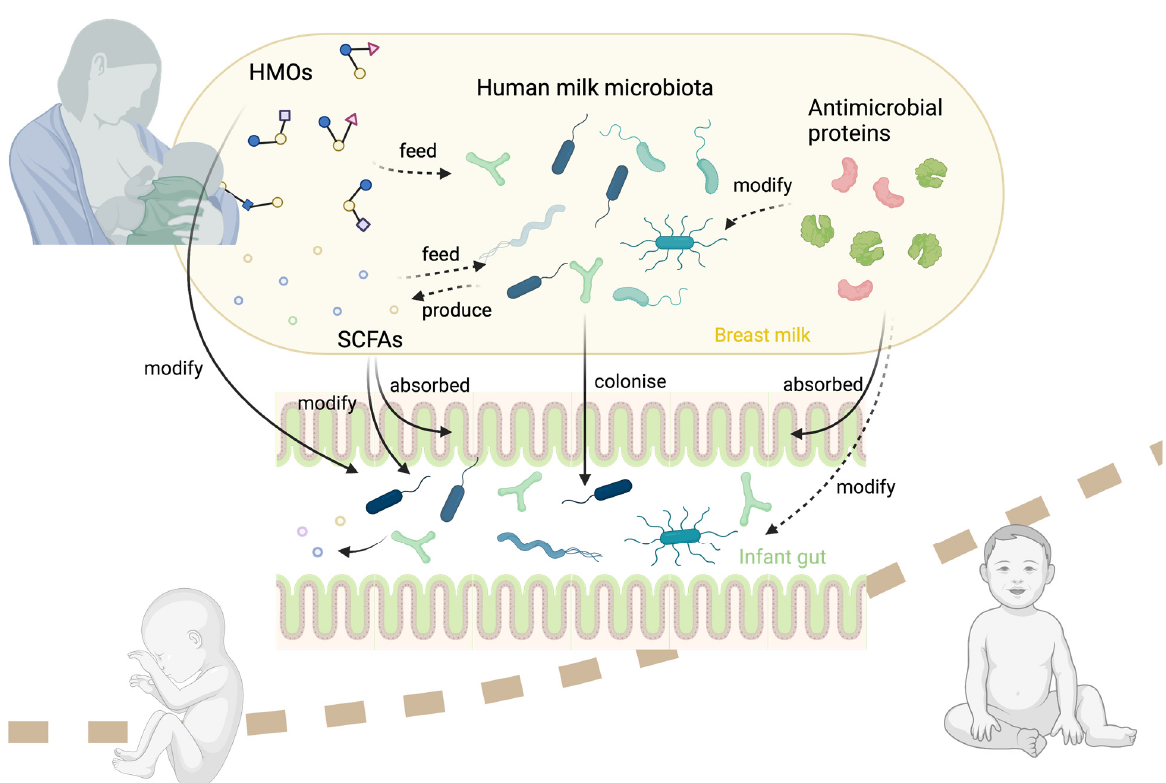
Figure 1. Potential interactions between human milk oligosaccharides (HMOs), microbiota, antimi- crobial proteins, and short-chain fatty acids (SCFAs), within the mammary gland, and their influence on infant growth via the infant gut microbiota.